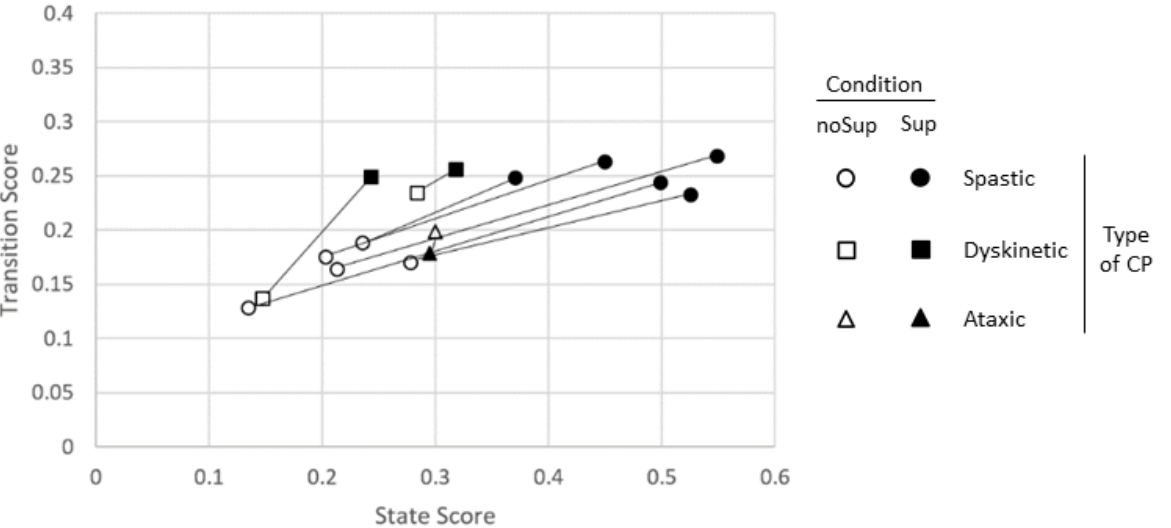
Figure 11. Comparison of state and transition scores for all subjects. Each subject’s no support and support score markers are connected by a line. Data points in the lower left portion of the grid indicate mostly poor posture (time spent and transitions toward Collapse or Rise and Fall), while those in the upper right quadrant indicate improved posture (time spent and transitions moving towards Wobble, Stable, or Head).